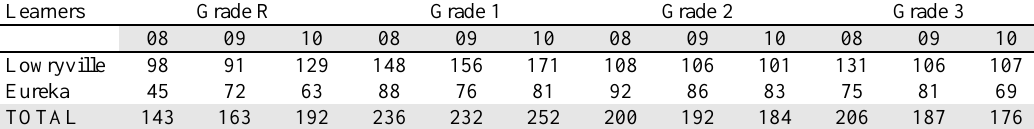
Table 2 Number of learners who participated in the programme 2008-2010